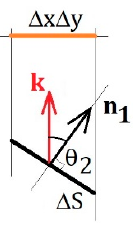
Figure 10. Relationship between the area segment ∆ S of the pond bottom reflection point and its projection ∆ x ∆ y onto the horizontal plane.